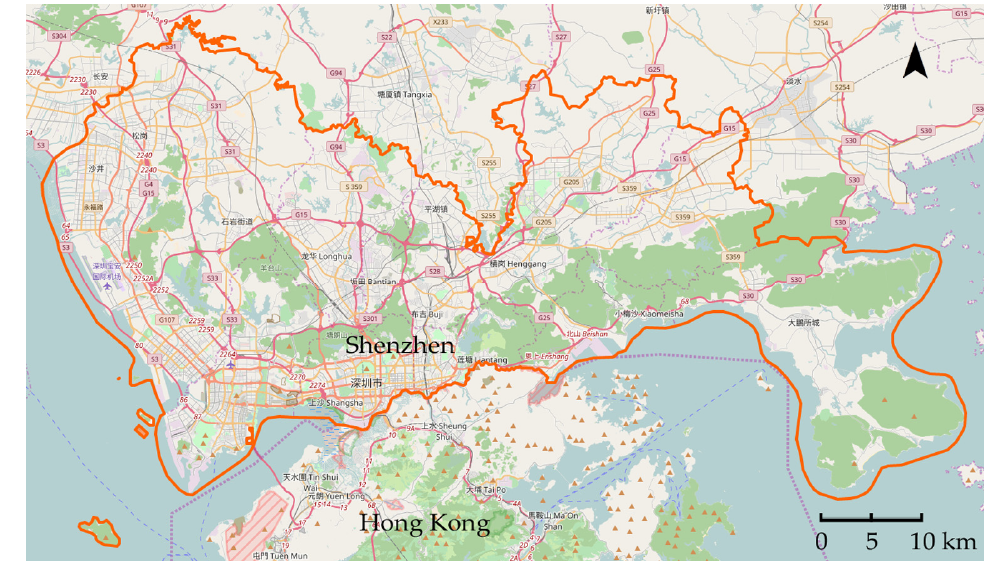
Figure 2. Location of Shenzhen (from OpenStreetMap).